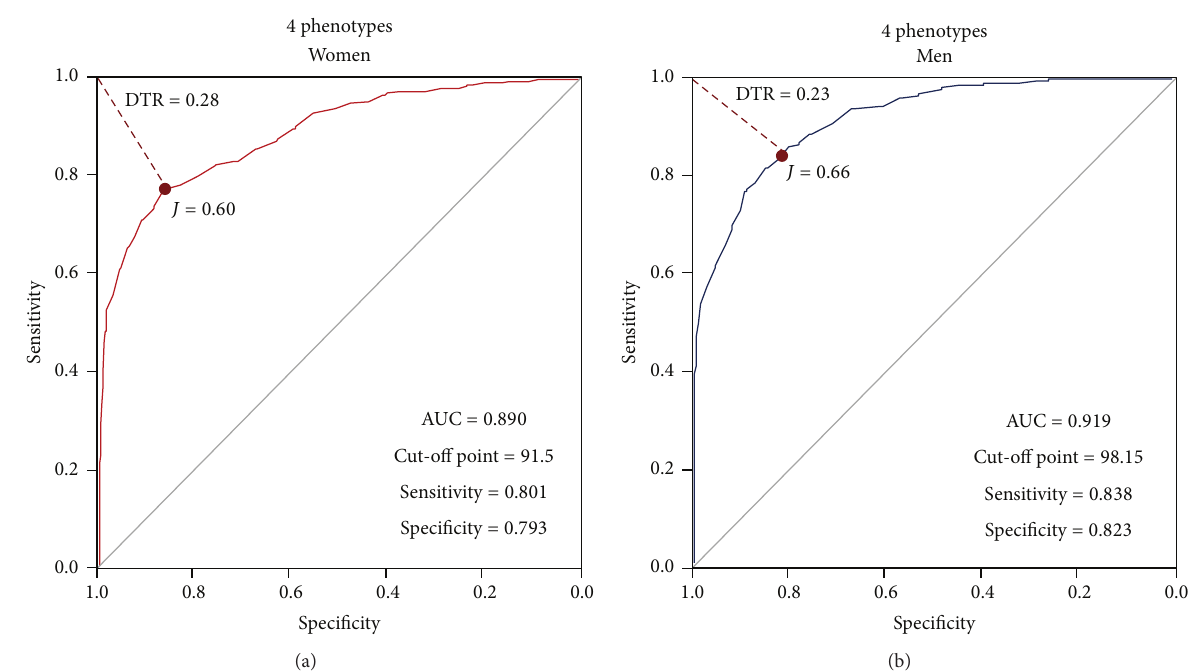
Figure 4: ROC curves constructed using 4 phenotypes, after the exclusion of MOWN and MHO